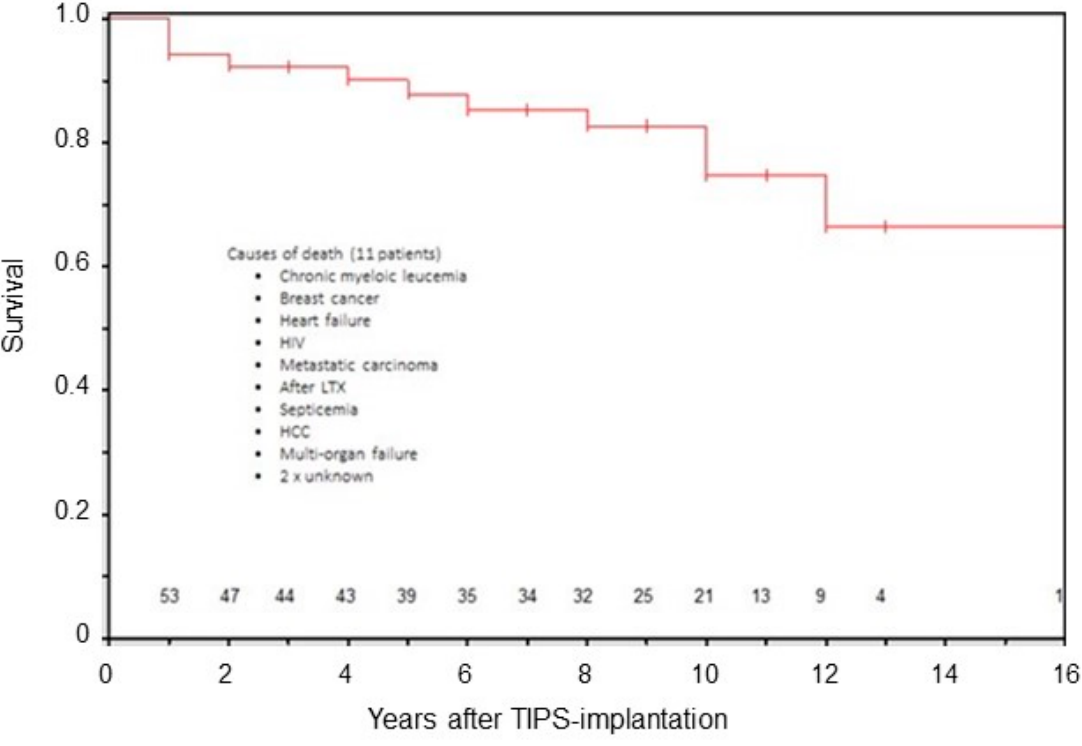
Figure 9. Survival of patients after TIPS implantation. Two patients were transplanted; one of them died.